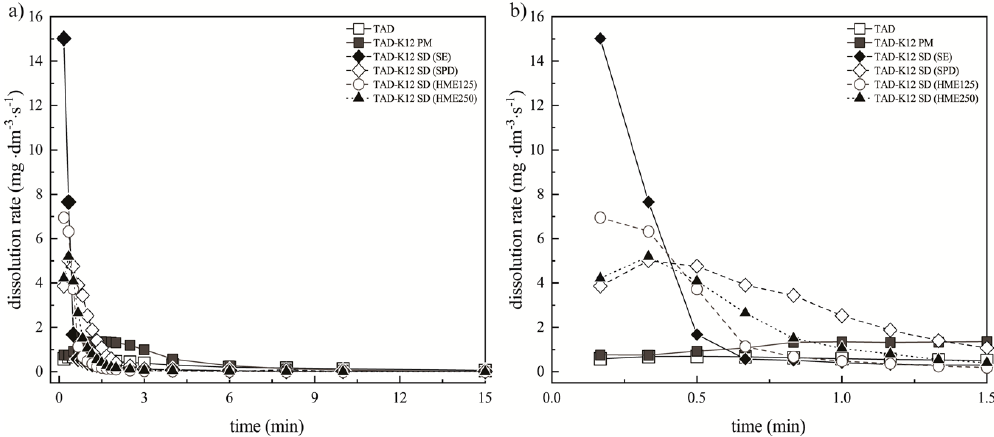
Figure 11. Dissolution rates of TAD from PM and SDs containing K12: ( a ) during 15 min and ( b ) during 1.5 min.